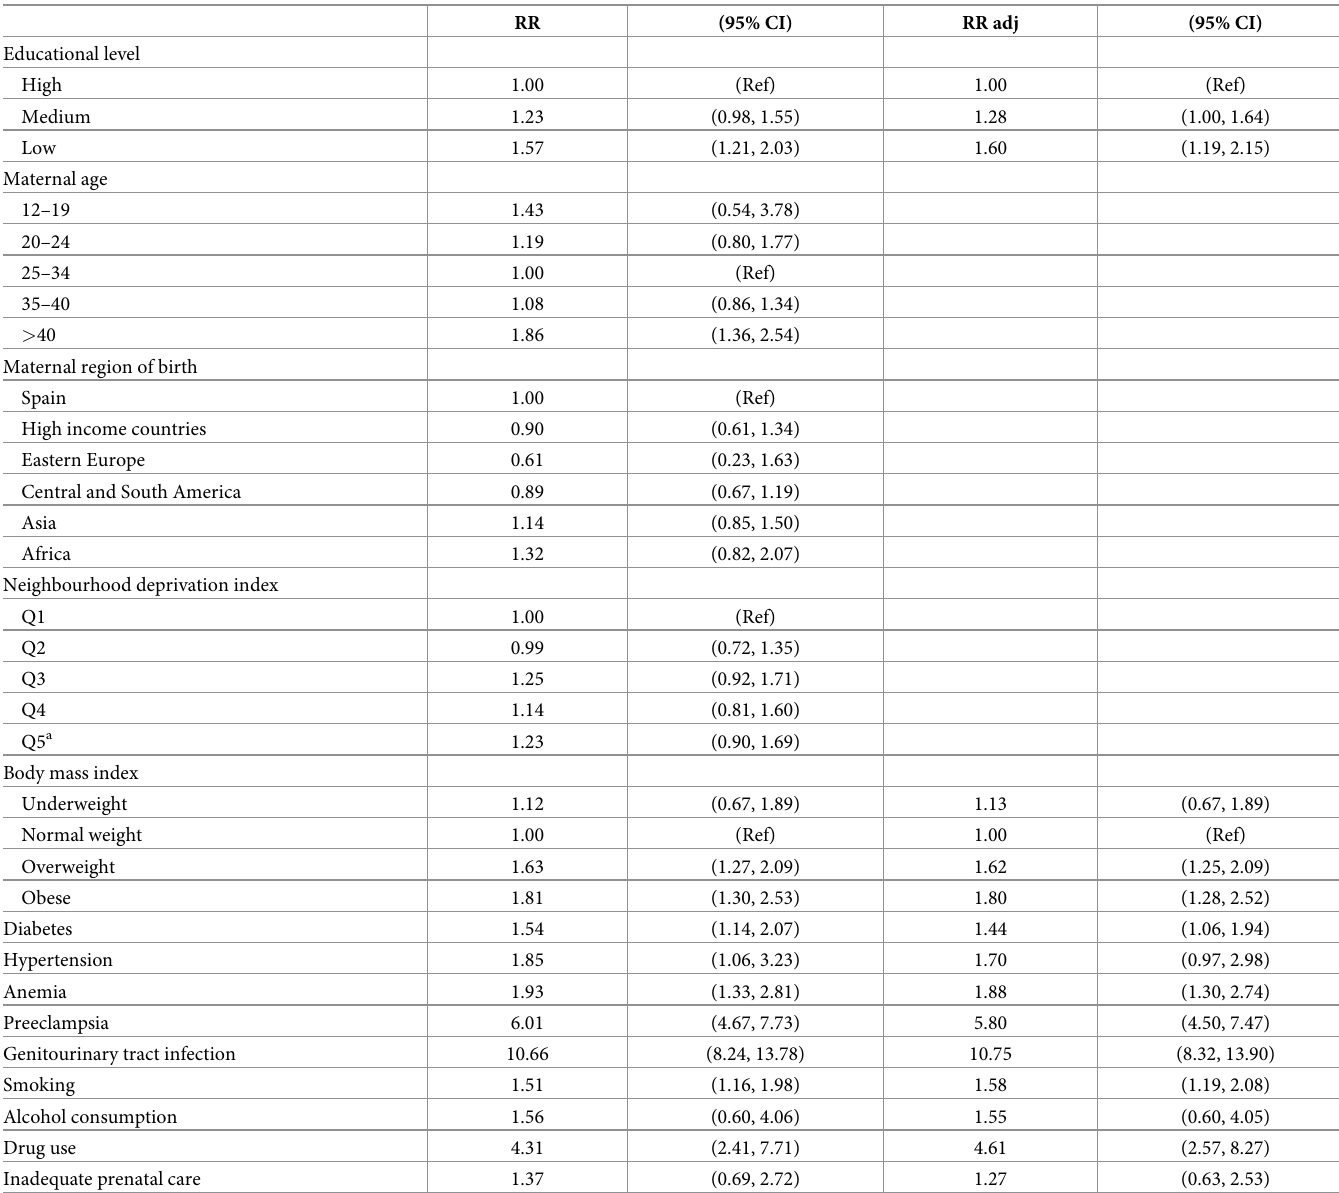
Table 2. RR for the association of preterm birth with educational level, preterm birth with confounder variables and preterm birth with intermediate variables.